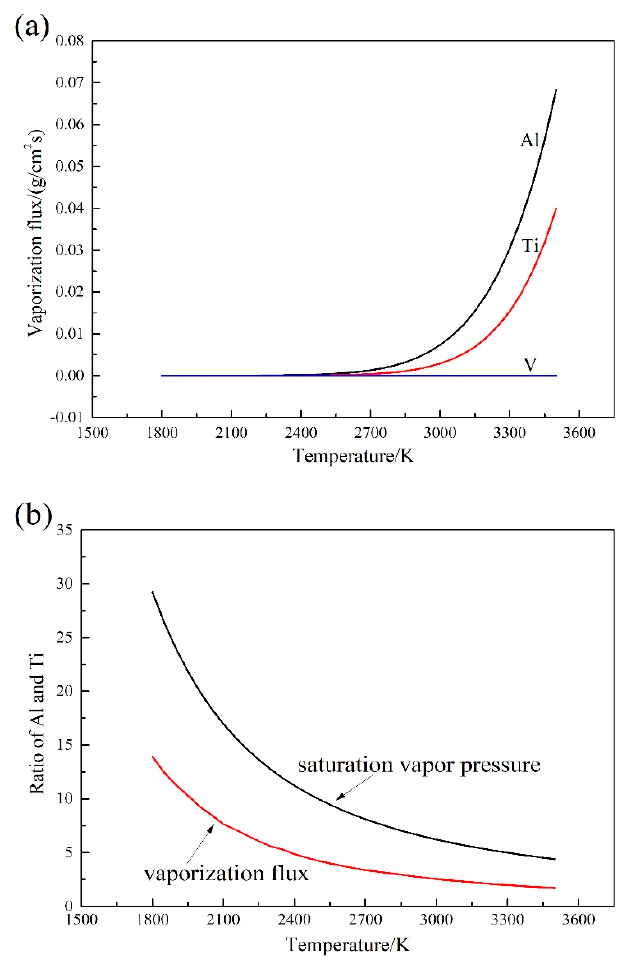
Figure 3. Kinetic calculation results of element vaporization: ( a ) relationship between vaporization fluxes of different elements and temperature; ( b ) ratio of saturation vapor pressure and vaporization flux of Al and Ti.